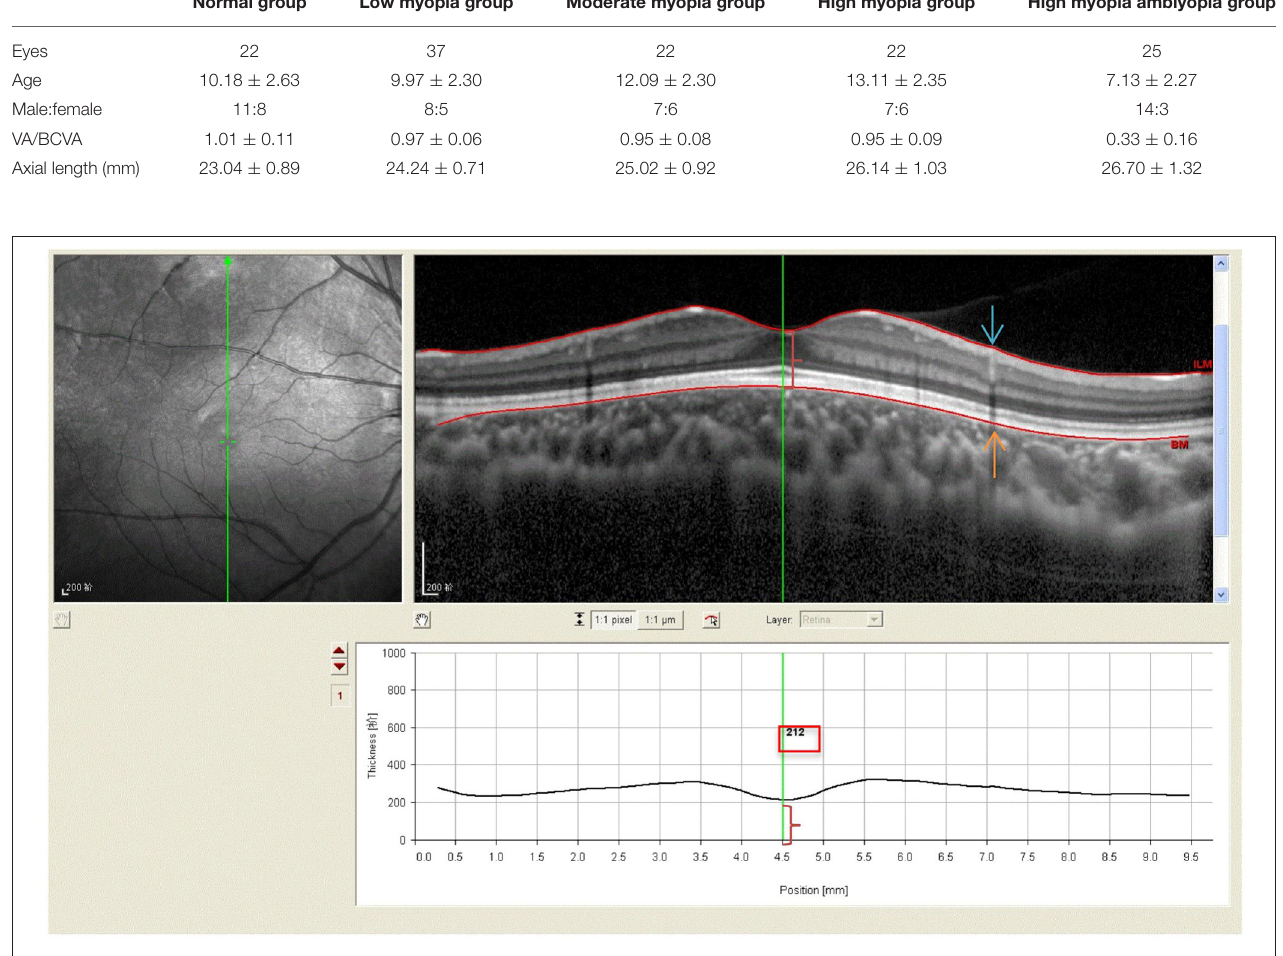
TABLE 1 | Demographic and clinical data for each group. Normal group